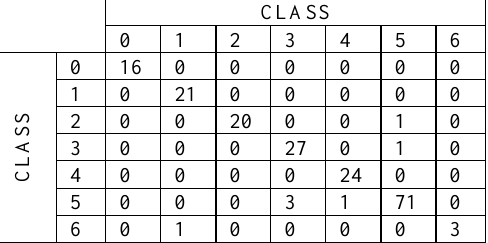
Table 5 . Confusion matrix.